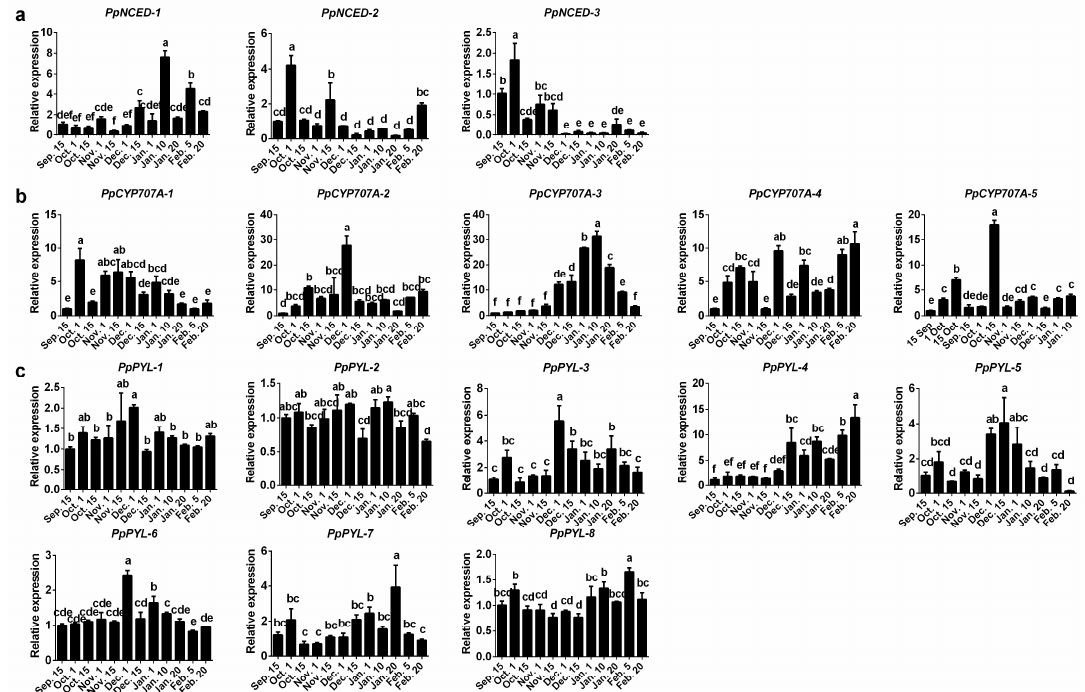
Figure 4. Relative gene expression levels of ABA metabolism and receptor genes during pear flower bud dormancy on 2016–2017. Expression values were normalized to the value of the PpACTIN gene. Each bar represents the mean ± SEM of three biological replicates. Different letters indicate a significant difference among different dates ( p < 0.05).